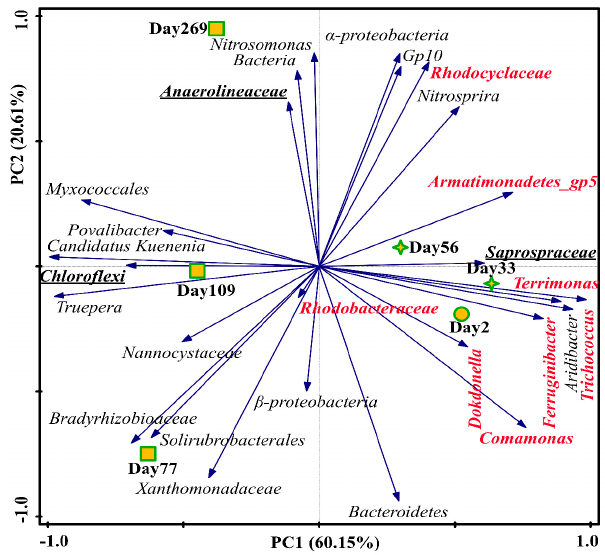
Figure 6. Microbial communities for the three stages based on the top 10 abundant genera in each sample (species marked in red represents denitrifying bacteria; bold underlined species represents filamentous bacteria).